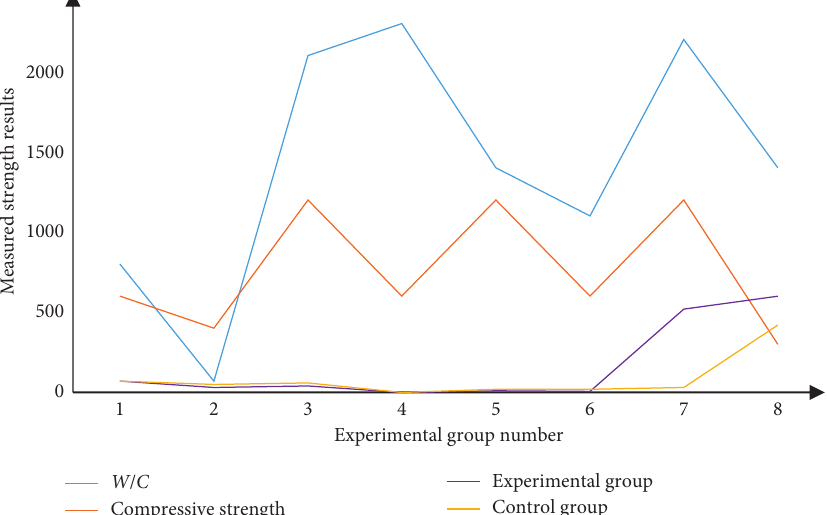
Figure 2: The effect of W / C value on the compressive strength of fiber-reinforced magnesium phosphate cement-based nanocomposites in bridge structure repair and reinforcement.